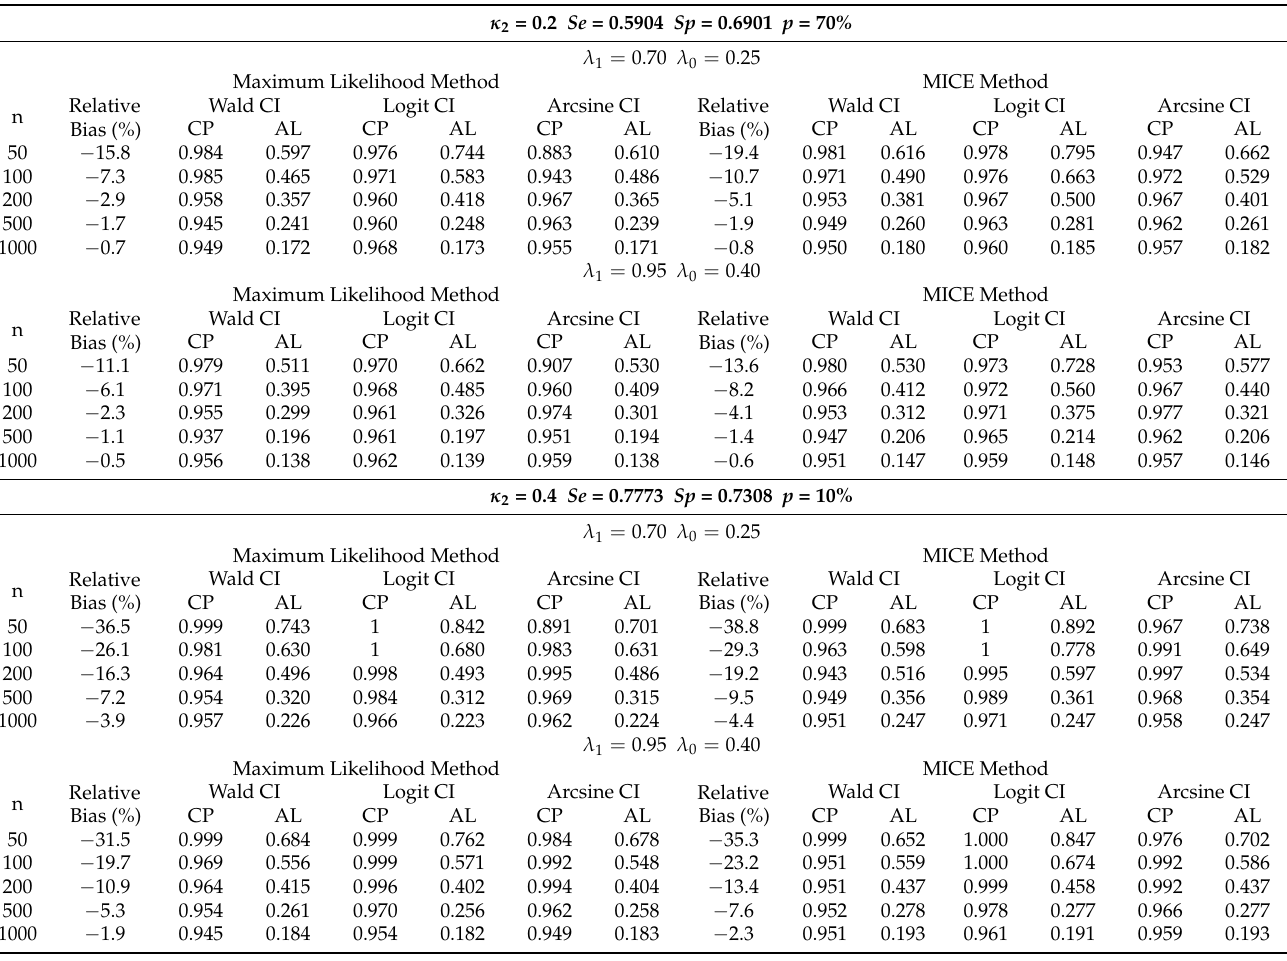
Table 5. Coverage probabilities and average lengths of CIs for κ 2 = { 0.2,0.4 }